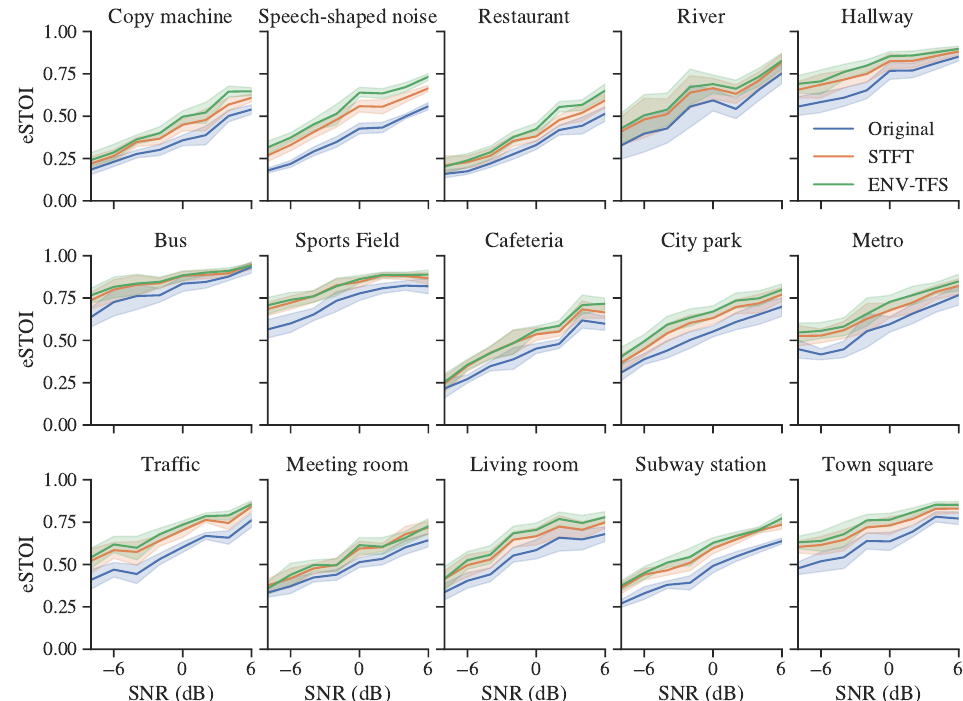
Figure 4. Objective intelligibility scores of the utilized speech enhancement systems in di ff erent noise types. The sub-figures illustrate the mean eSTOI scores (with shaded confidence interval 95%) for the proposed system (ENV-TFS), the baseline system (STFT) and the unprocessed samples (Original) with respect to di ff erent SNR values.